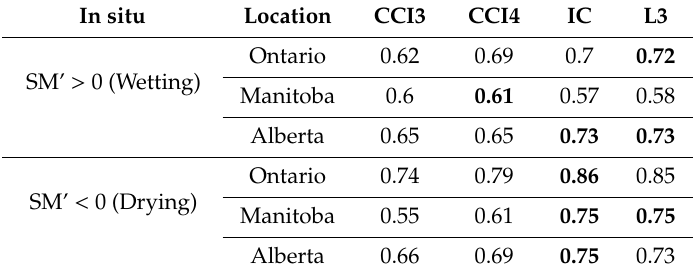
Table 2. Proportion of positive and negative SM anomaly values captured by each satellite product as compared to in situ networks. The highest ratio values for each location and for each sign of anomaly are shown in bold.